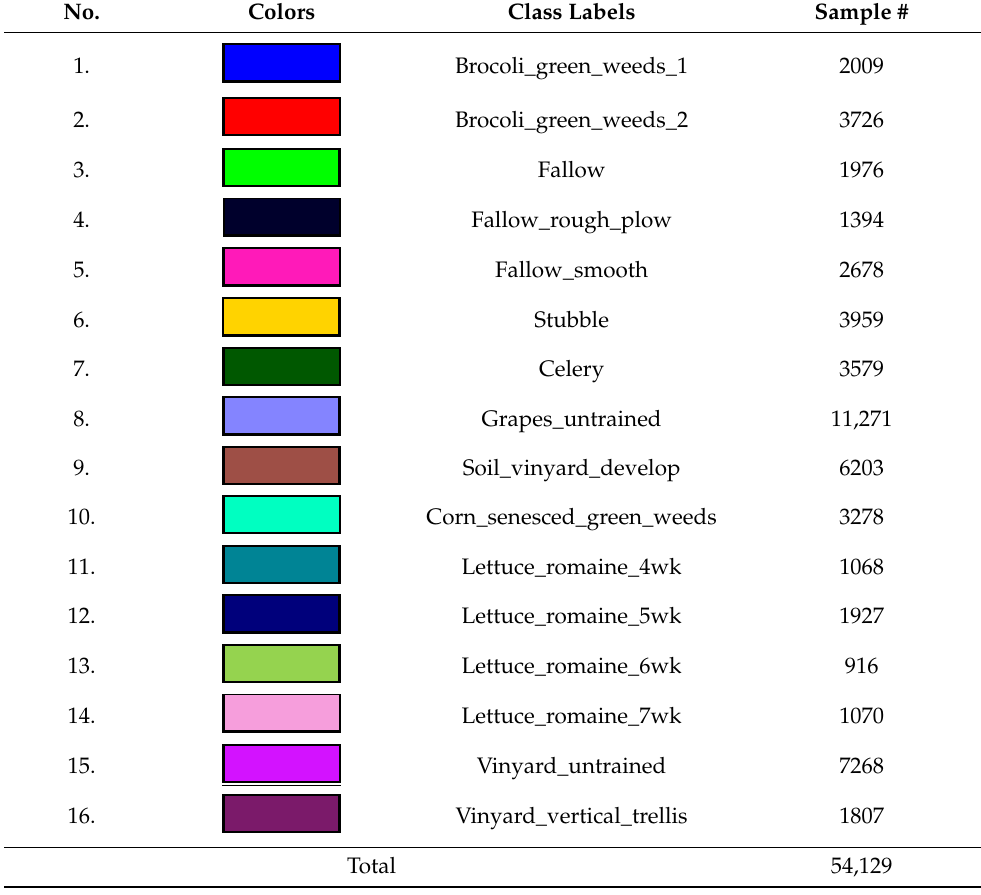
Figure 4. The analysis for the training data in dataset Salinas: ( a ) The overlapping degrees of various values α , ( b ) The visualized training sample distribution of PCA and 𝑟 = 0.41 , ( c ) The visualized training sample distribution of value 𝛼 = 0 and 𝑟 = 0.34 , ( d ) The visualized training sample distribution of value 𝛼 = 0.95 and 𝑟 = 0.18 , and ( e ) The visualized training sample distribution of value 𝛼 = 1 and 𝑟 = 0.07 . Table 3. Pixel numbers of dataset Salinas.